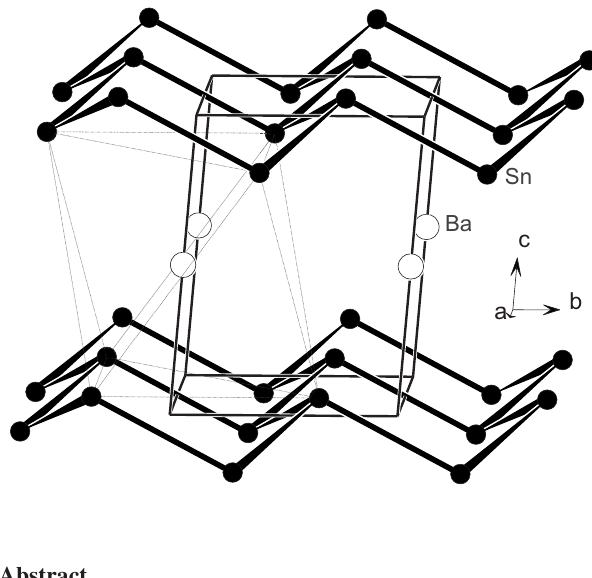
Table 1. Data collection and